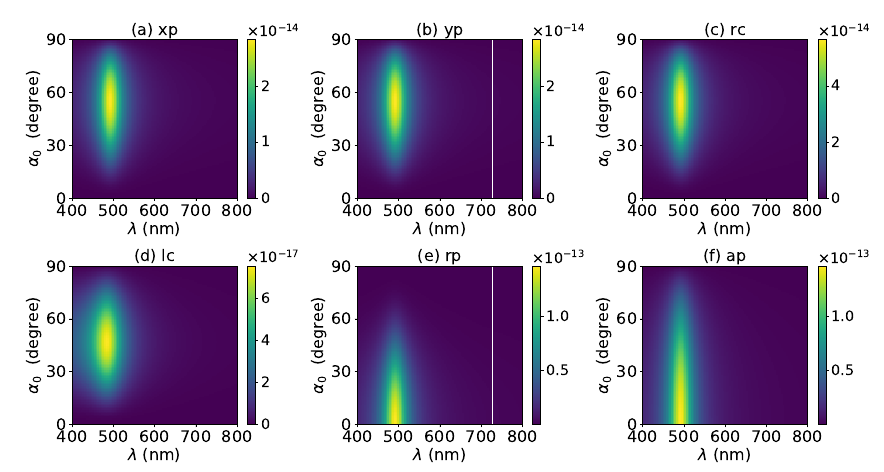
Figure 8. The same as in Figure 7, but with N = 1.